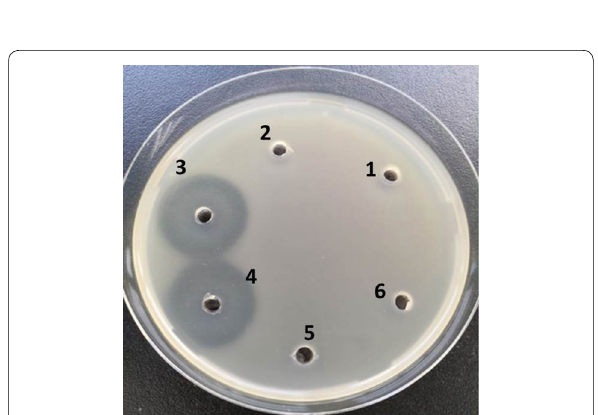
Fig. 3 Antibacterial activity of HPLC collected samples. 1, 2, 3, 4, 5, 6 respectively represent the received samples from period 0.0–1.0 min, 1.0–5.1 min, 5.1–5.5 min, 5.1–5.5 min, 5.5–6.5 min, 6.5–7 min. No. 3 and 4 is both from 5.1–5.5 min which have antibacterial activity against E.coli . The experiment was repeated three times